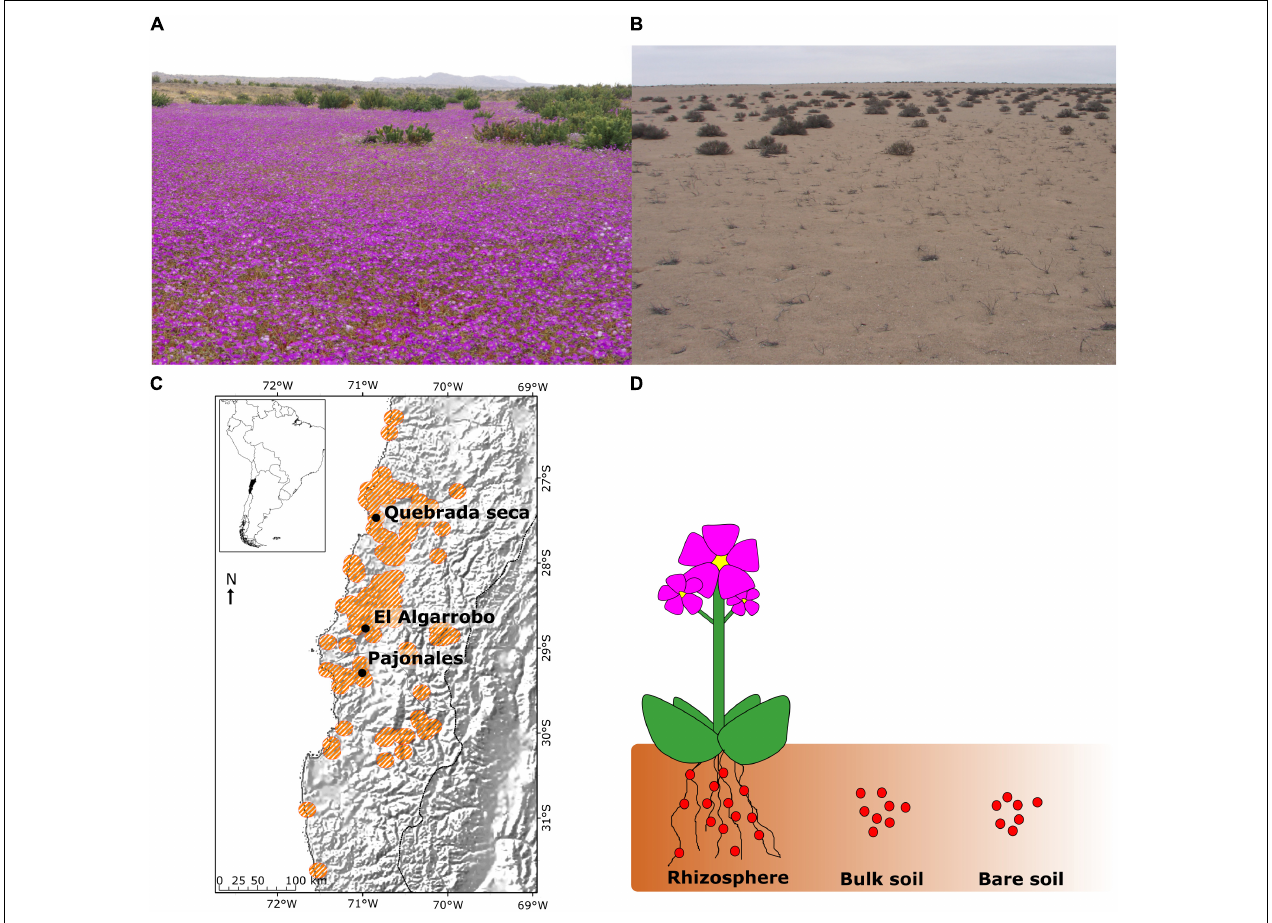
FIGURE 1 | Natural habitat of Cistanthe longiscapa , sampling sites and sampling strategy per site. (A) Photograph of C. longiscapa population in a rainy year; (B) Photograph of C. longiscapa population in a dry year; (C) Geographical localization of sampling sites in Quebrada Seca, El Algarrobo, and Pajonales; (D) Schematic illustration of sample types from each site: starting from a C. longiscapa individual three sample types were distinguished: Rhizosphere, Bulk soil, and Bare soil ∗ . ∗ Bare soil was only collected at site Quebrada Seca, for comparison of rainy and dry